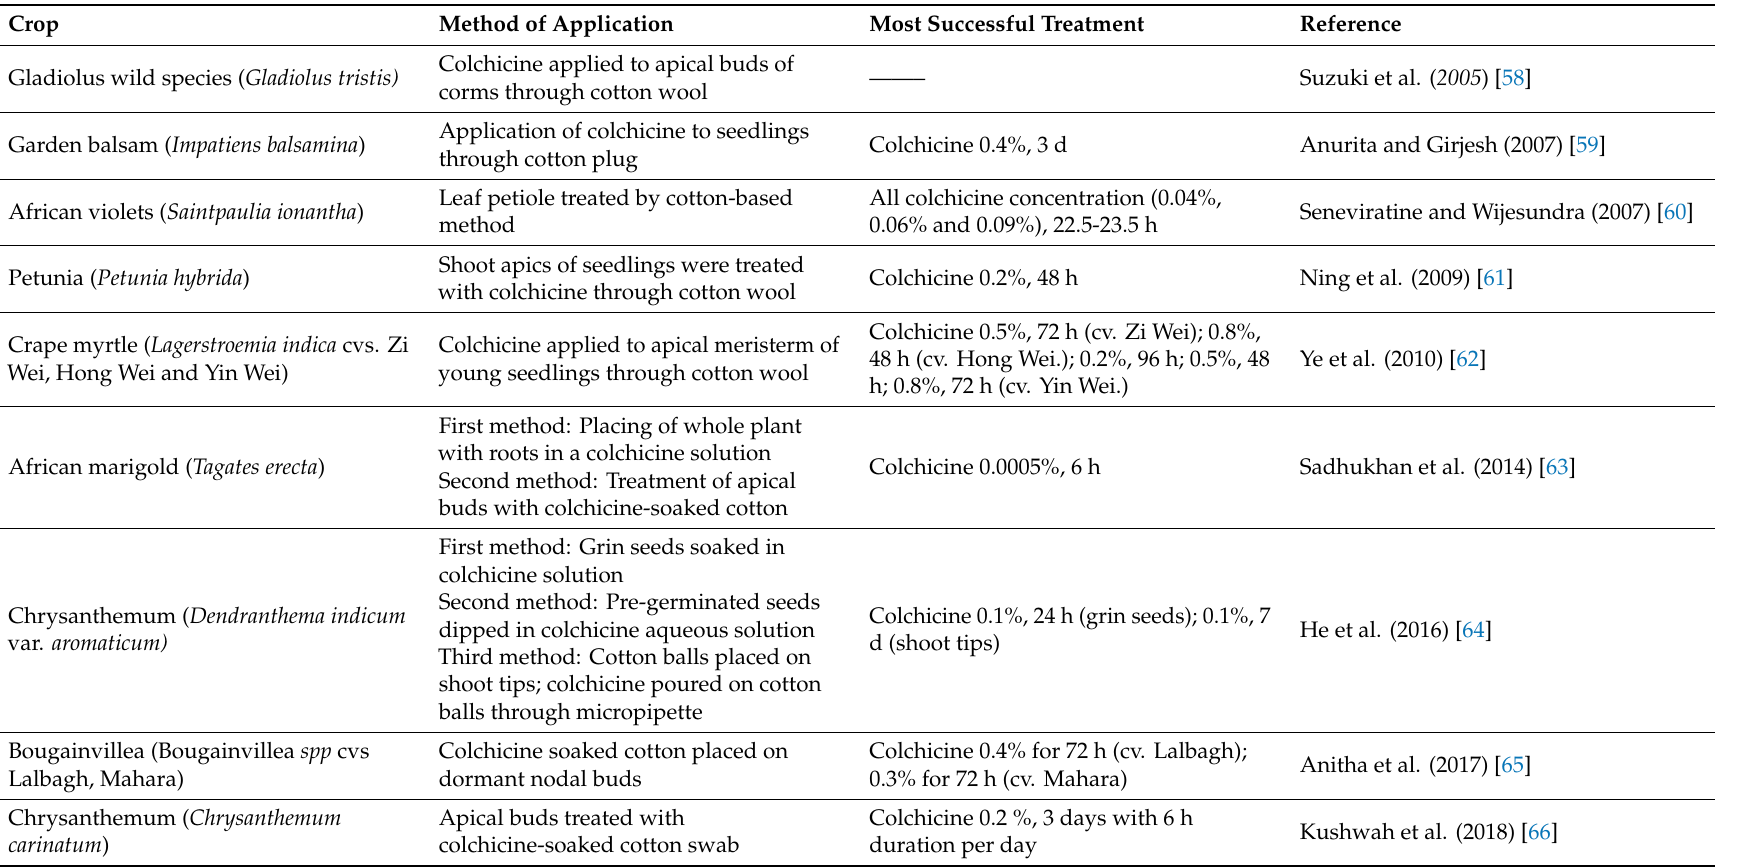
Table 2. Induction of polyploidy in ornamental plants by applying colchicine through cotton wool method since last fifteen